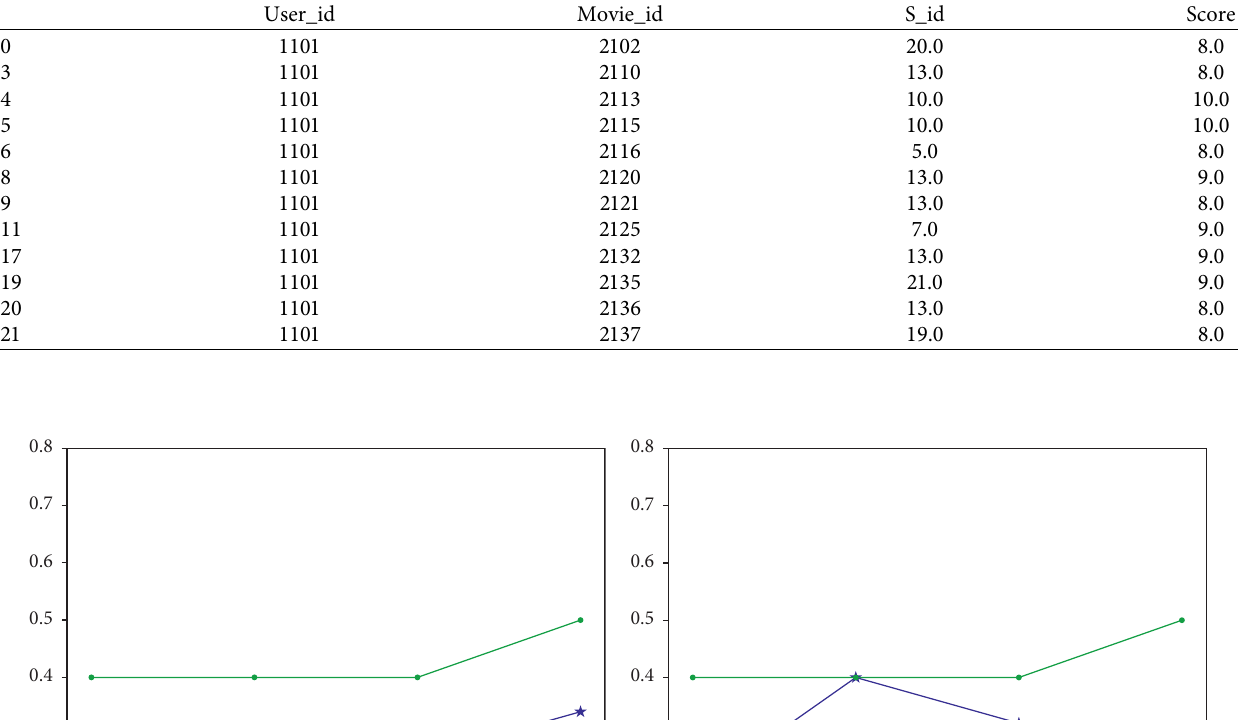
Table 1: The items that users prefer (part).